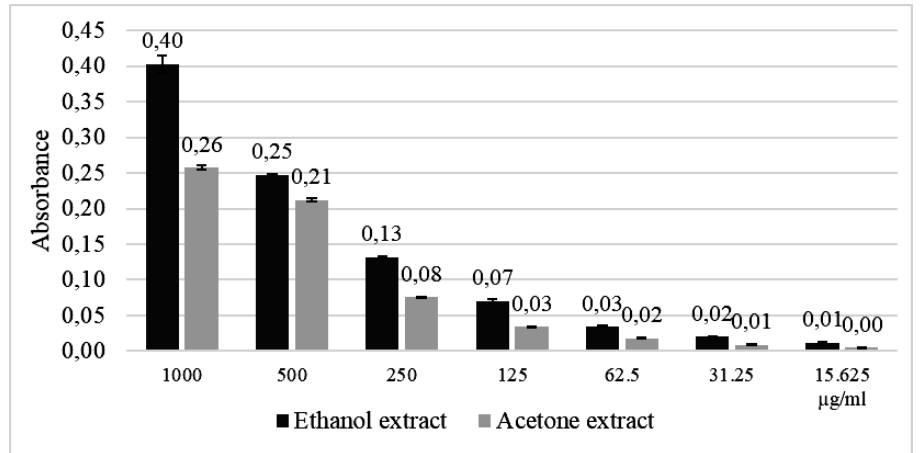
Figure 5. Reducing power of ethanol and acetone extracts of T.